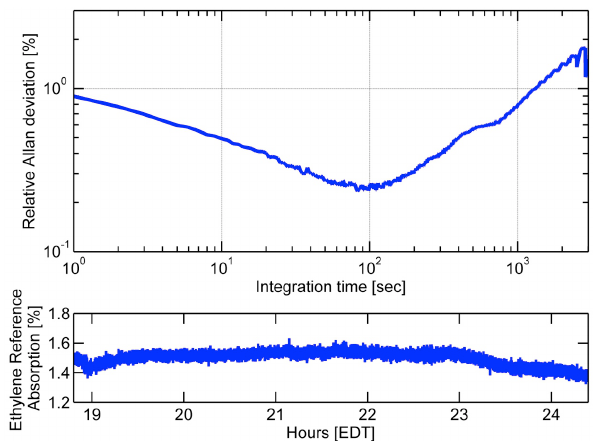
Fig. 6. Allan deviation plot of in-line ethylene reference cell signal Figure 6. Allan deviation plot of in-line ethylene reference cell signal and associated 5.5 hour 2 and associated 5.5h time series. The Allan deviation is expressed as time series. The Allan deviation is expressed as a percent of the mean value of the reference 3 a percent of the mean value of the reference signal time series (rel- signal time series (relative Allan deviation). Ethylene is recorded at 1 Hz time resolution. 4 ative Allan deviation). Ethylene is recorded at 1Hz time resolution.